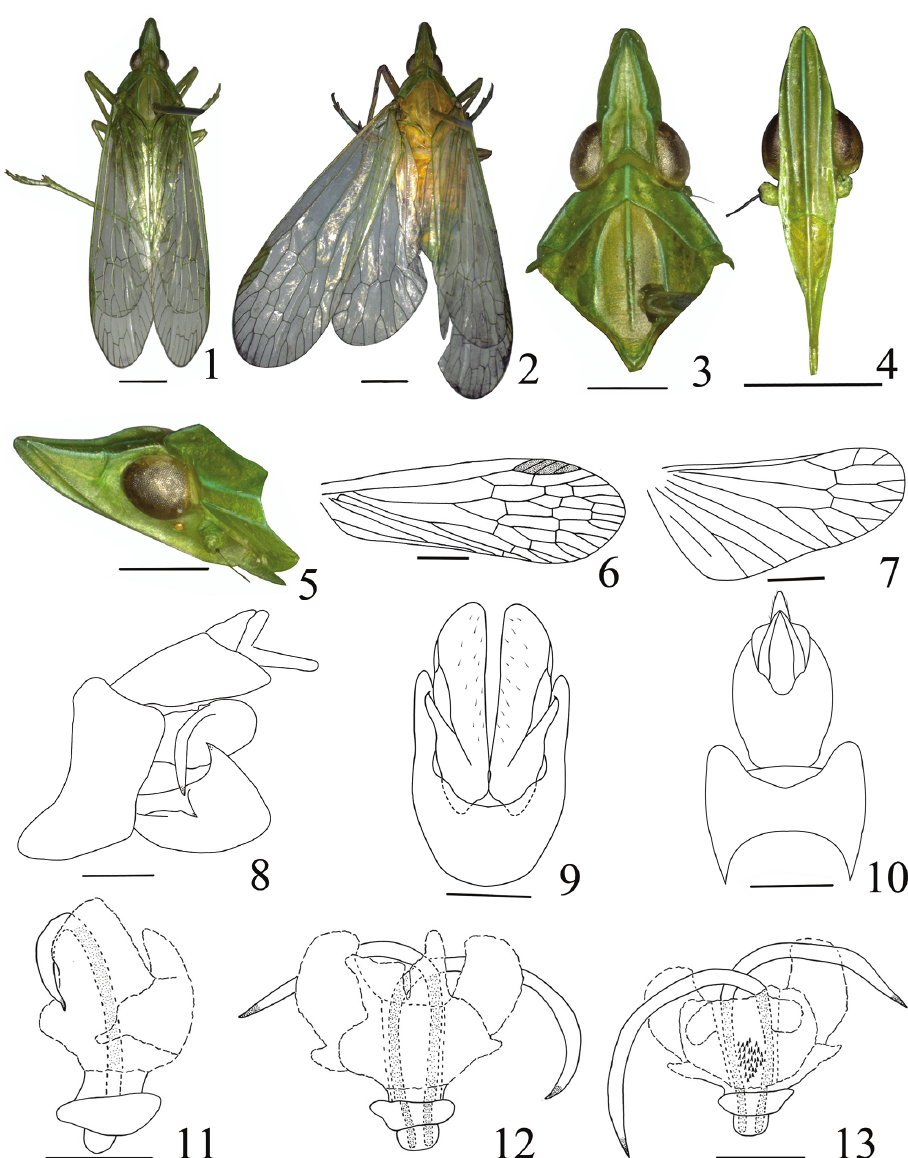
Figures 1–13. Tenguna kuankuoshuiensis sp. n. 1 male, holotype 2 female 3 Head and thorax, dorsal view 4 Frons and clypeus, ventral view 5 Head and pronotum, lateral view 6 Forewing 7 Hind wing 8 Pygofer and anal tube, dorsal view 9 Pygofer and parameres, ventral view 10 Genitalia, lateral view 11 Aedeagus, lateral view 12 Aedeagus, ventral view 13 Aedeagus, dorsal view. Scale bars: 1–7 2 mm; 8–13 0.5